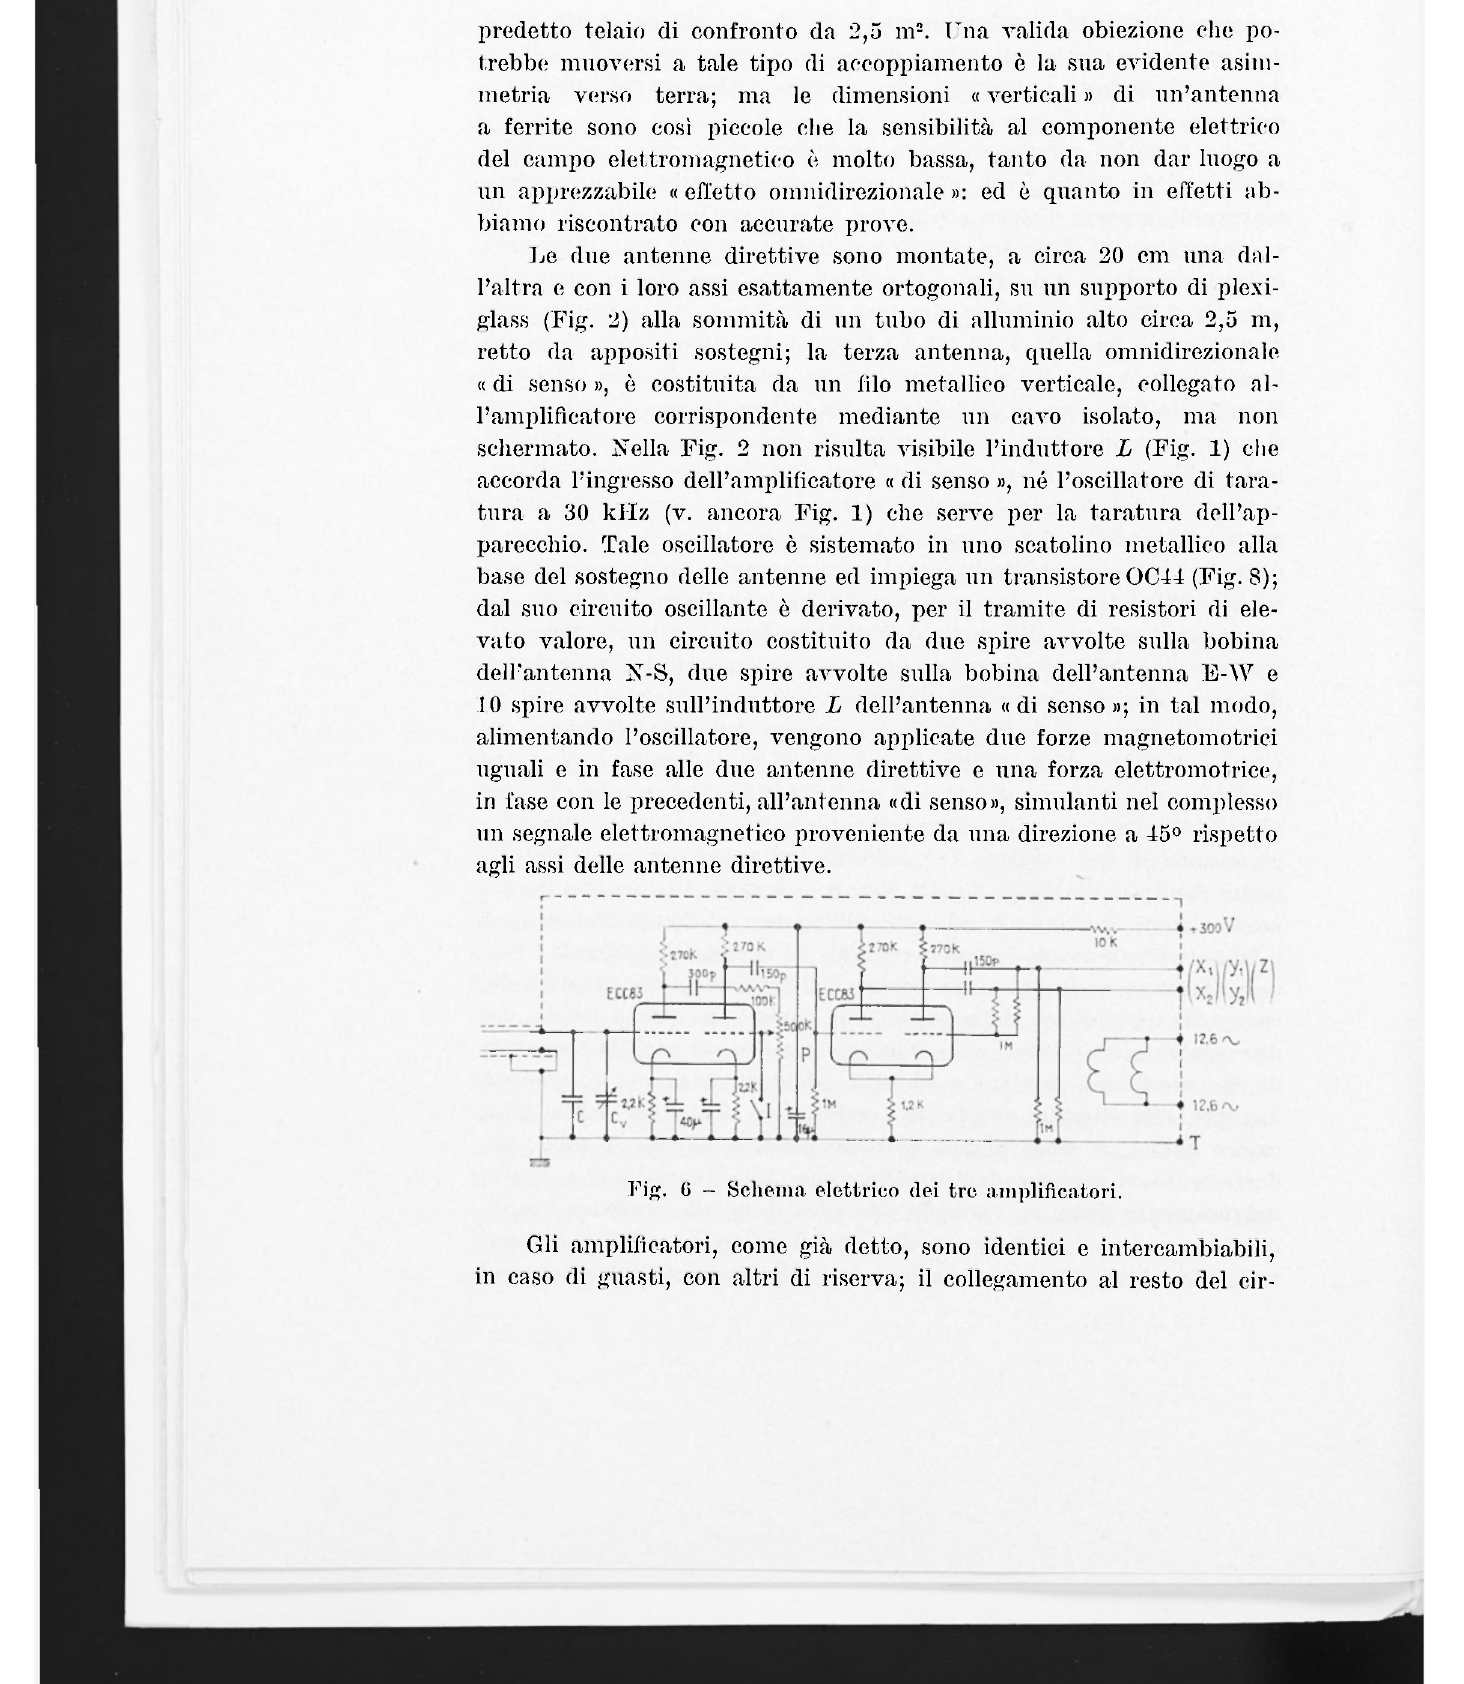
Fig. 6 - Schema elettrico dei tre